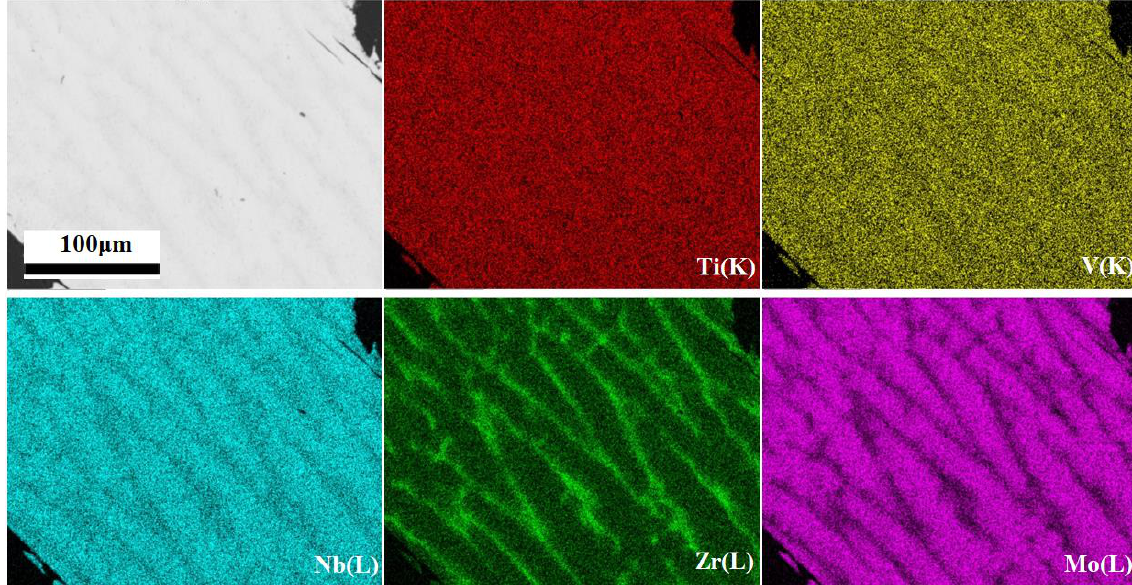
Figure 2. BSE image and EDS mapping analysis of the as-cast alloy Ti 0.30 V 0.25 Zr 0.10 Nb 0.25 Mo 0.10 alloy. The BSE image is in grey, and the five chemical elements are mapped as follows: Ti(K)—red, V(K)—yellow, Nb(L)—cyan, Zr(L)—green and Mo(L)—magenta.